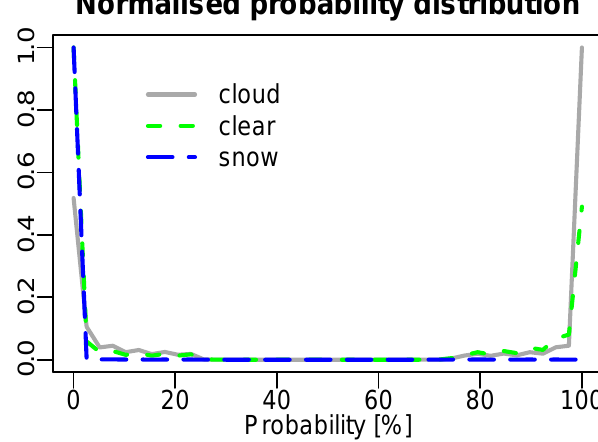
Fig. 15. PCM normalised probability distribution for clear, cloudy and snow conditions derived from annual counts of the NOAA18 satellite data. For details see Sect.